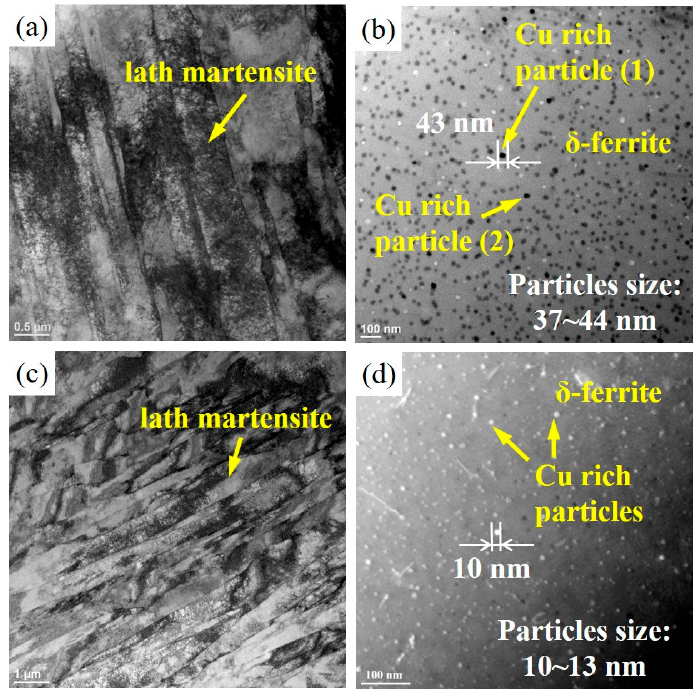
Figure 5. Microstructures of H2O-quenched solid solution samples for ( a ) lath martensite and ( b ) Cu-rich nanoparticles in ferrite; and that of liquid N2-quenched samples for ( c ) lath martensite and ( d ) Cu-rich nanoparticles in ferrite.